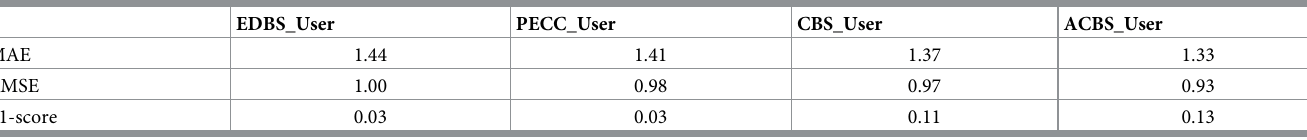
Table 8. Comparison of various methods using vital